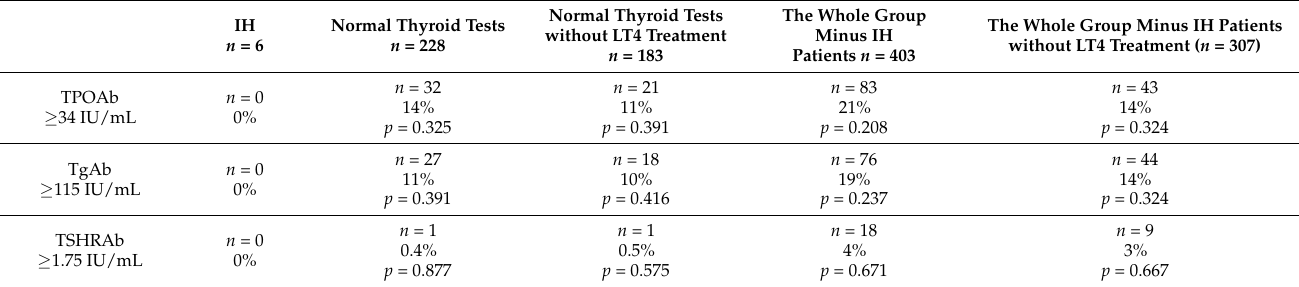
Table 4. Percentage of positive thyroid antibodies in patients with isolated hypothyroxinemia (IH) vs. patients with normal thyroid tests (additionally after excluding individuals on L-thyroxine (LT4) treatment) and vs. the whole group of 466 inpatients minus patients with IH (additionally after excluding individuals on L-thyroxine (LT4) treatment). Normal Thyroid Tests The Whole Group IH Normal Thyroid Tests The Whole Group Minus IH Patients without LT4 Treatment Minus IH n = 6 n = 228 without LT4 Treatment ( n = n = 183 Patients n = 403